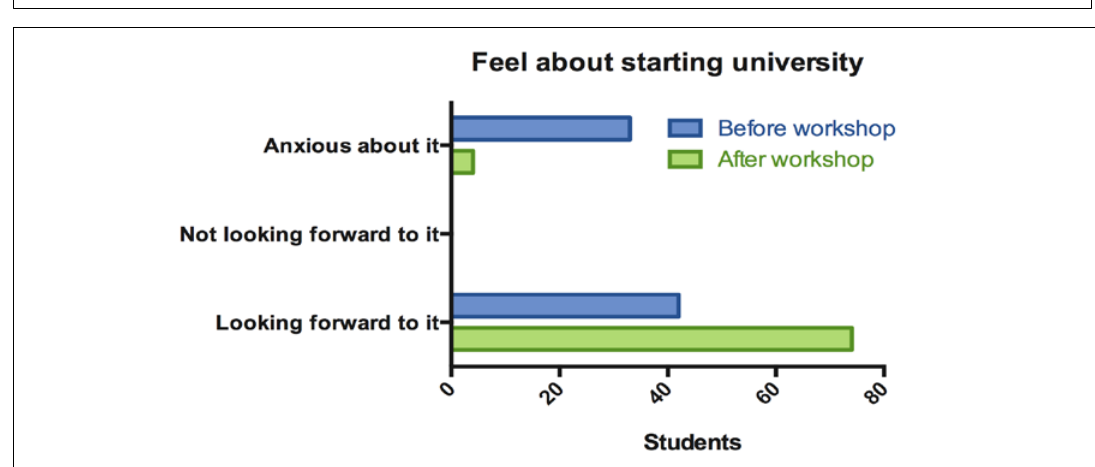
Figure 3 : Students’ feelings about starting